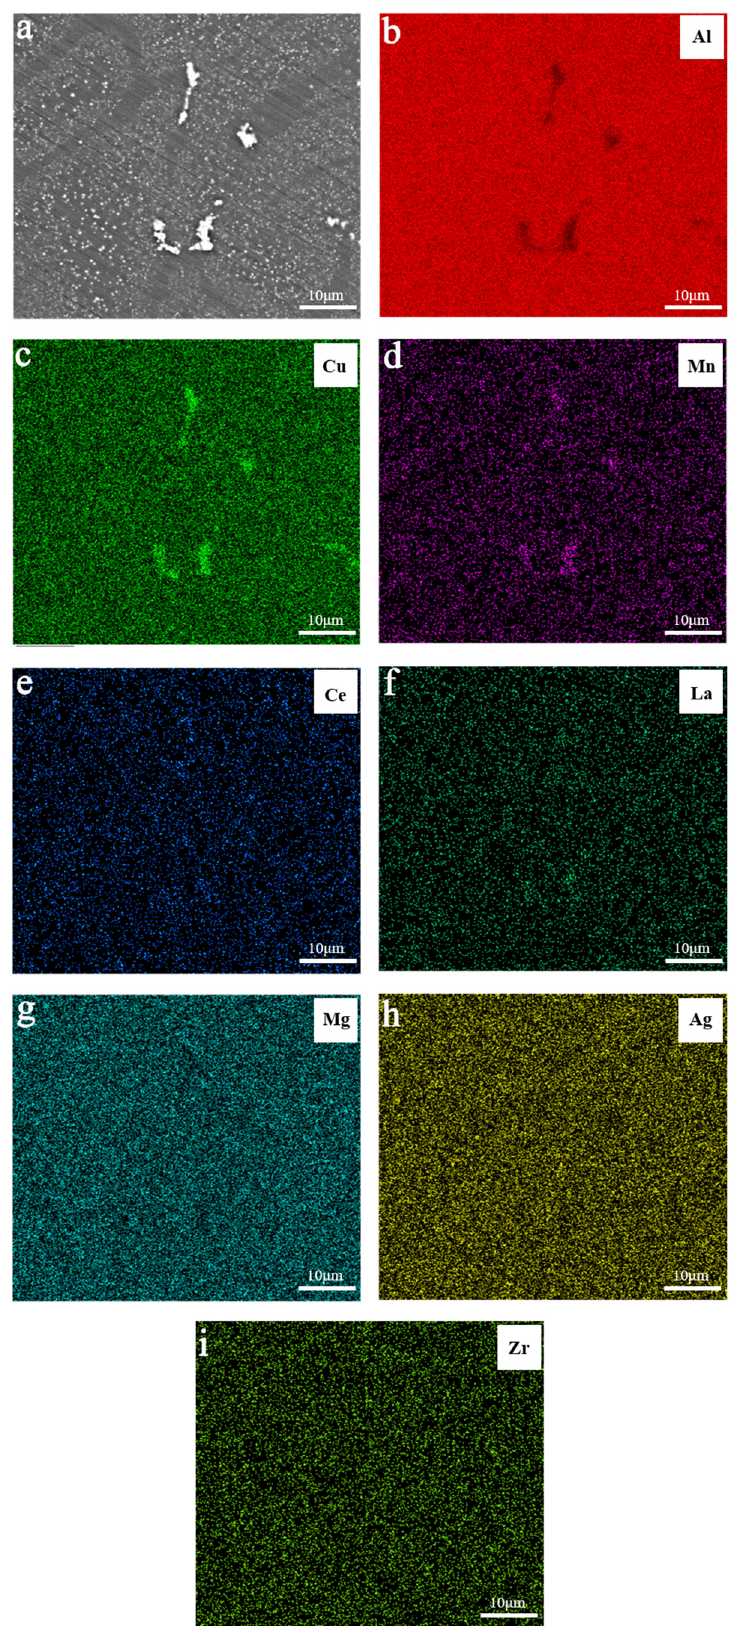
Figure 10. ( a ) Backscattered SEM images and elemental mapping images of the aged alloys: ( b )